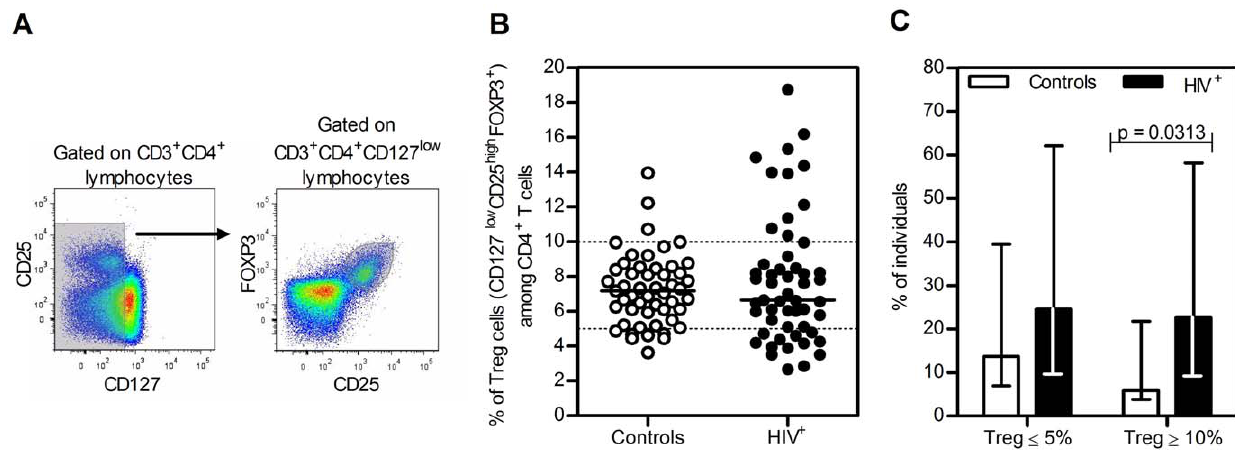
Figure 1. High variability of Tregs percentages in HIV + individuals. A. Representative dot plots from an HIV + individual illustrating the gating strategy for Tregs analysis. Lymphocytes (selected according to FSC and SSC) were gated on CD3 + CD4 + cells, on low or no expression of CD127 and on the expression of FOXP3 and high levels of CD25. B. Tregs percentages amongst CD4 + T cells in control and HIV + individuals. Each dot represents a single individual and the lines the median Tregs percentages within CD4 + T cells. Dashed lines represent the range of Tregs percentages among total CD4 + T cells described for healthy individuals (between 5% and 10%) [51]. C. Percentage of individuals with Tregs # 5% and $ 10% in controls and HIV + individuals. P-value for the comparison of these proportions (Chi-square test) and the 95% confidence interval are